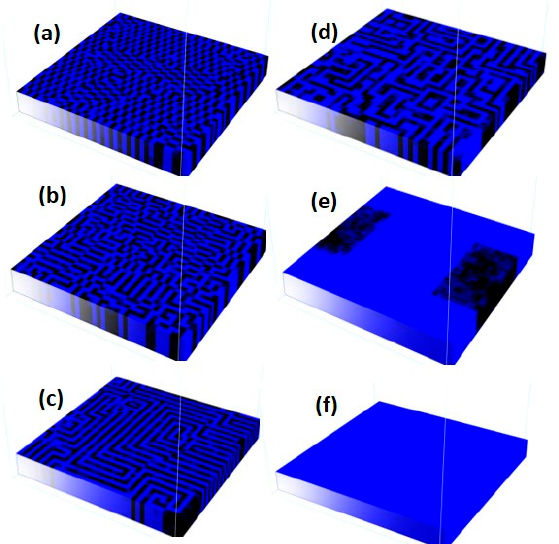
Figure 7. Evolution characteristic of magnetic configurations. Blue indicates magnetic alignments in the − x direction and black indicates alignments in the + x direction. Column: 𝐾 = 0.3 . ( a ) 𝐽̅ = 0.1 ; ( b ) 𝐽̅ = 0.3 ; ( c ) 𝐽̅ = 0.5 ; ( d ) 𝐽̅ = 1.0 ; ( e ) 𝐽̅ = 2.0 ; ( f ) 𝐽̅ = 3.0 .